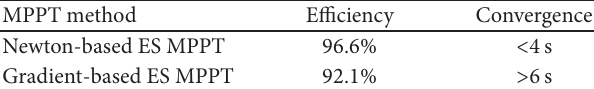
Table 4: The simulated comparison of the two methods.